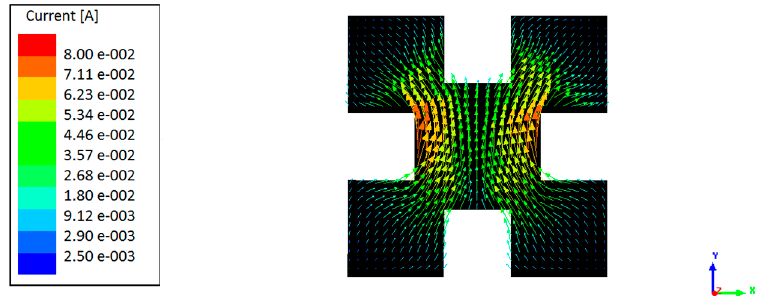
Figure 3. Current on the patch surface @ 868 MHz (D = 0.2 λ – L = 60.9 mm, S = 0.257). A MA unit cell, printed on a FR4 substrate ( ε r = 4.2, tan δ = 0.015, h = 3.2 mm), is designed by